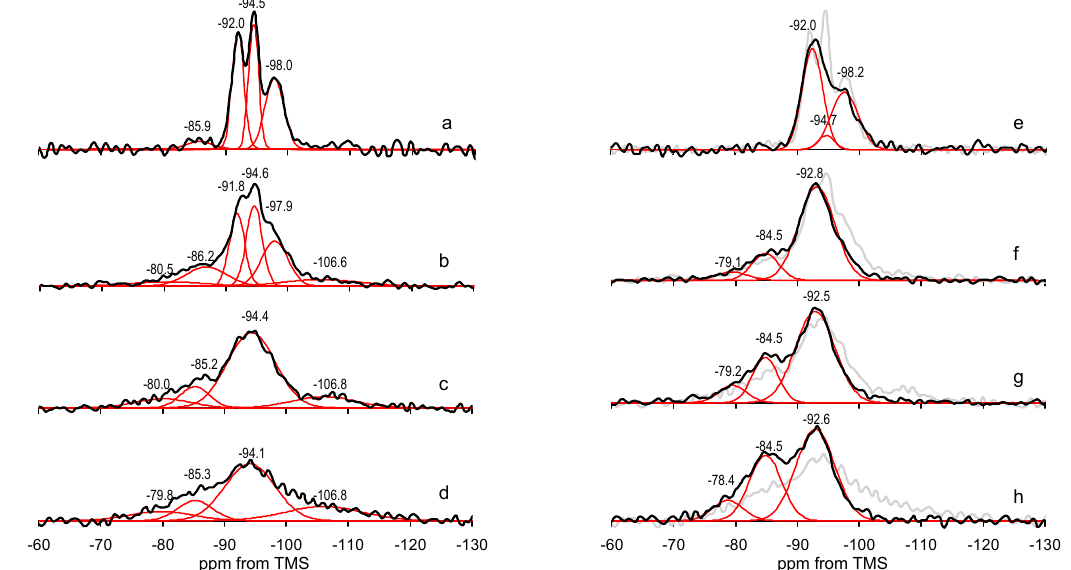
Figure 10. Evolution of 29 Si MAS NMR of sepiolite samples upon grinding: ( a ) Sep, ( b ) Sep / gr-10’, ( c ) Sep / gr-30’, ( d ) Sep / gr-60’ and after treatment with NaOH at 90 ◦ C for 24 h: ( e ) Sep / NaOH-24 h, ( f ) Sep / gr-10’ / NaOH-24 h, ( g ) Sep / gr-30’ / NaOH-24 h, ( h ) Sep / gr-60’ / NaOH-24 h. Red lines represent deconvoluted spectrum components. For comparison, the spectra of samples before alkali treatment are shown in grey.